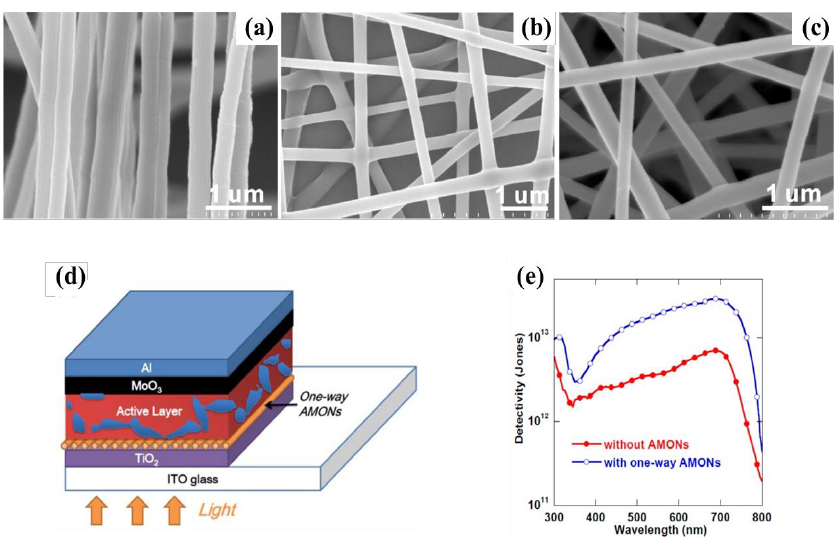
Figure 11. SEM images of ( a ) one-way of TiO 2 , ( b ) multiway of TiO 2 , and ( c ) random of TiO 2 ; ( d ) Device architecture of the OPD with one-way of TiO 2 as the HBL; ( e ) detectivities versus the wavelength under short circuits of OPDs without TiO 2 or with one-way TiO 2 . (Reproduced with permission from [10]. ACS Publishing, 2014).